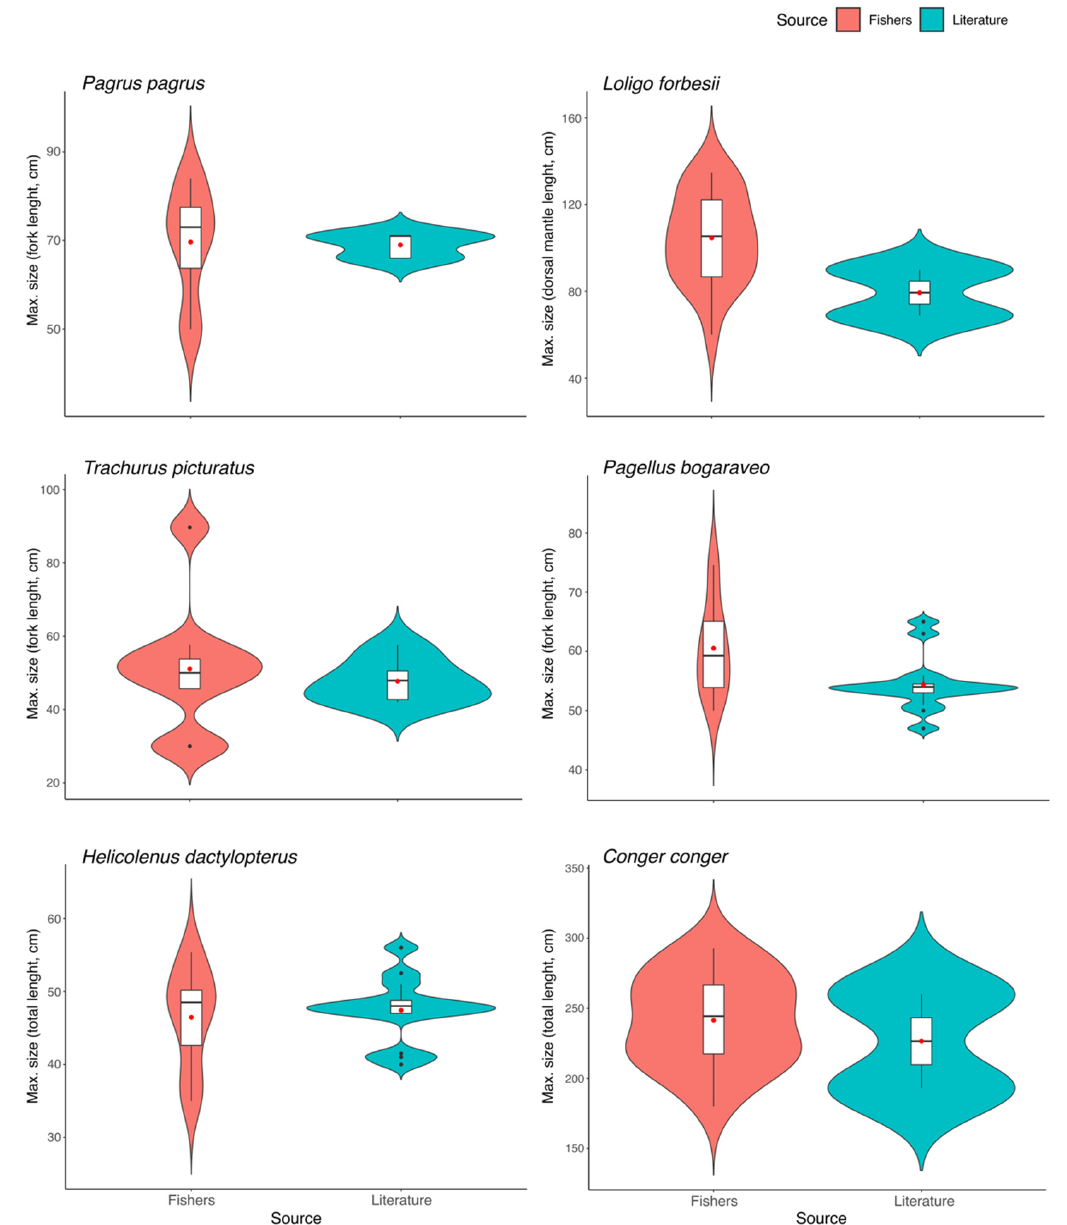
Figure 4. Maximum size (cm) of the species studied in the Azores according to fishers’ experiential knowledge and obtained from scientific literature [32]. Line inside the box represents the median, the box represents the interquartile range, the curves indicate the kernel probability density of the data at different values, and the red point represents the mean value. P. pagrus (no. of fishers’ responses = 14), L. forbesii ( n = 20), T. picturatus ( n = 9), P. bogaraveo ( n = 13), H. dactylopterus ( n = 8), C. conger ( n = 19).